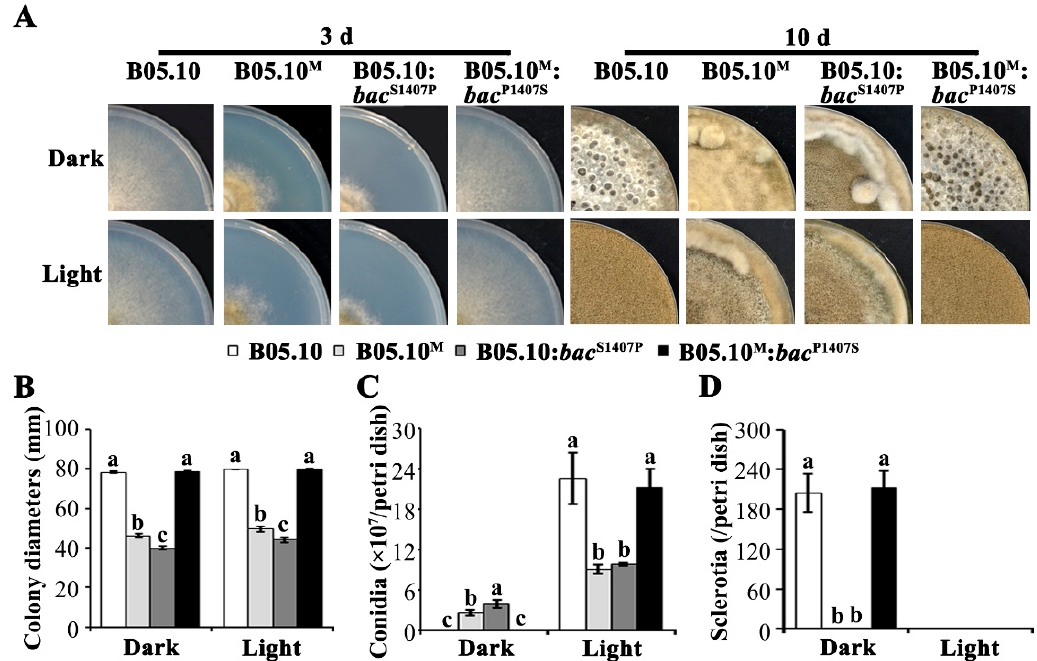
Figure 1. The S1407P mutation in bac resulted in defects in mycelial growth rate, sclerotial formation and conidiation. ( A ) Colony morphology of B05.10, B05.10 M , B05.10: bac S1407P , and B05.10 M : bac P1407S in dark and light on CM after incubation for 3 and 10 days. ( B ) Colony diameters for the above strains in dark and light after incubation for 3 days. ( C , D ) Number of conidia ( C ) and sclerotia ( D ) per Petri dish formed on CM after 10 days of incubation, respectively. Different letters on the columns indicate significant differences ( p < 0.05).